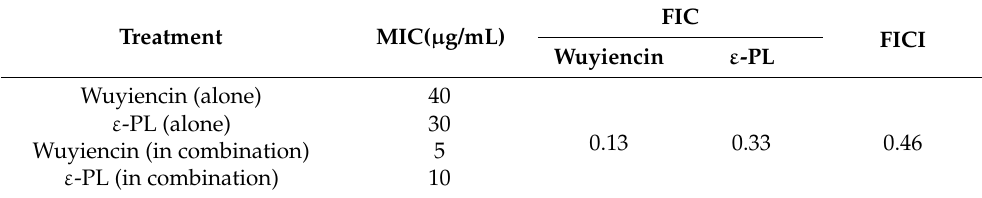
Table 5. The FICI of ε -PL combined with wuyiencin against B.cinerea .